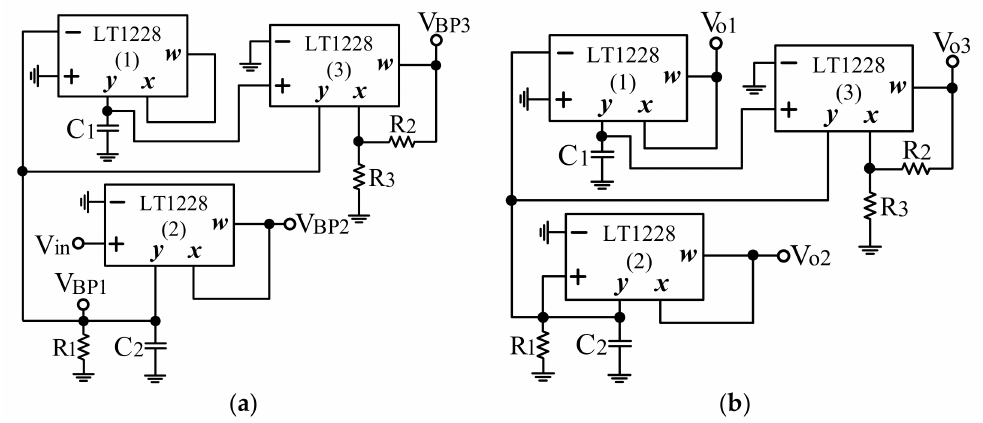
Figure 2. The first proposed isomorphic circuit of the VM NBPF and VM QSO. ( a ) VM NBPF circuit. ( b ) VM QSO circuit.